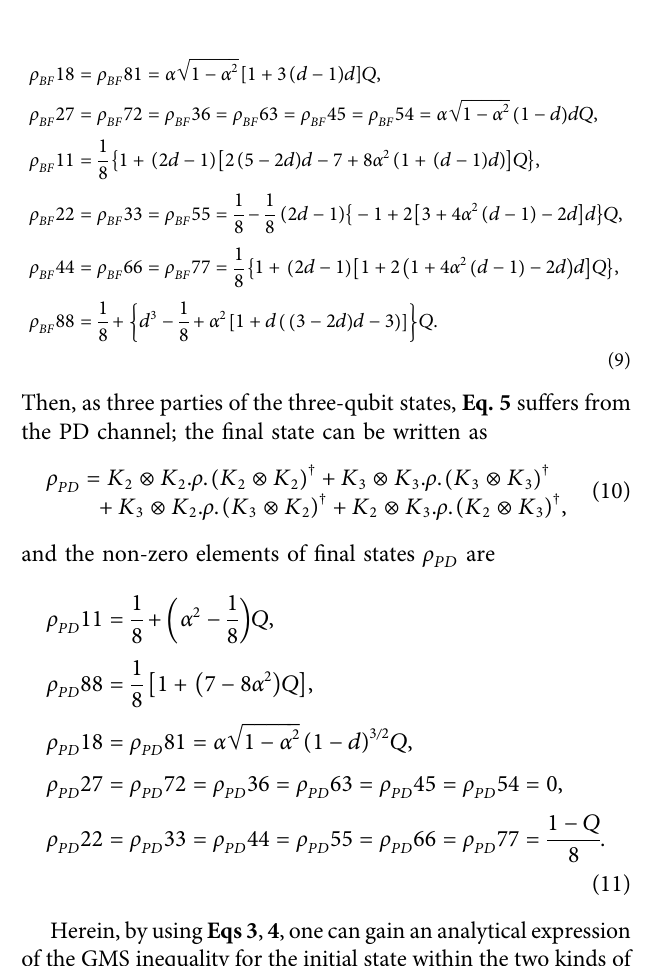
Frontiers in Physics |